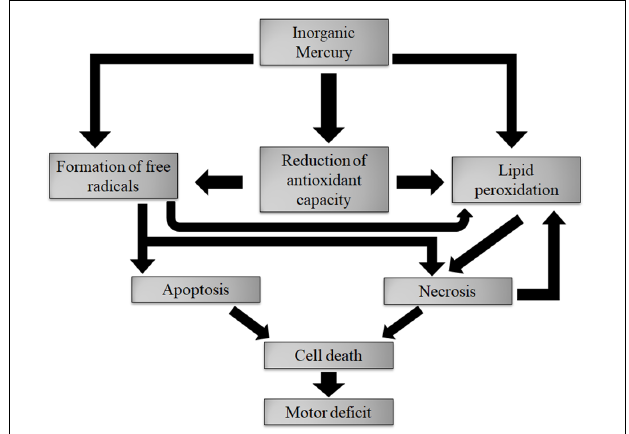
FIGURE 10 | Description of the main results found in this article. Deposits of inorganic mercury caused oxidative stress. The necrosis and apoptosis processes kill cells, both neurons and glia. The cell death is the main factor responsible for fine motor control changes.